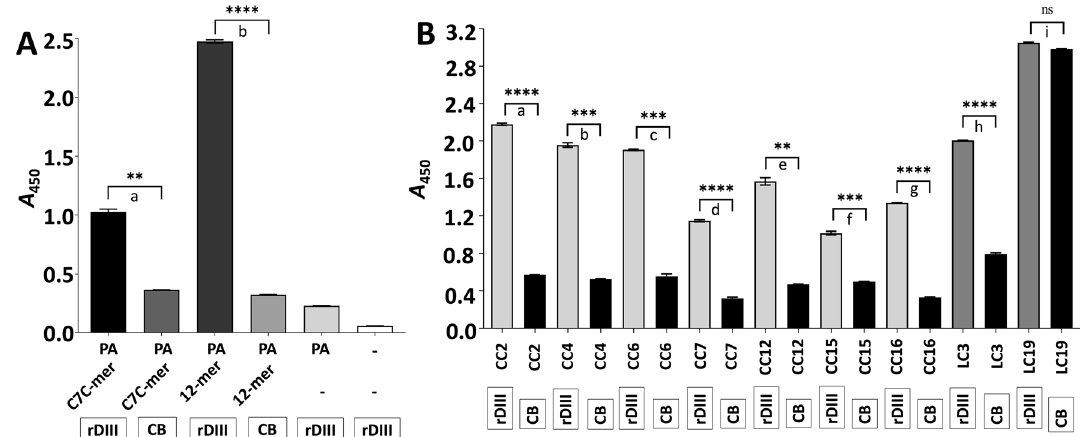
Figure 1. Confirmation of the interaction between rDIII and amplified phages using semi-quantitative ELISA. ( A ) Phage ELISA demonstrating the interaction between rDIII and C7C-mer and 12-mer phages amplified from the last round of biopanning. ( B ) Phage ELISA demonstrating the interaction of individual C7C-mer and 12-mer phage clones to rDIII. Framed reagents were coated into microtiter wells. Data present mean of triplicates with ± S.D. Asterisks indicate statistical significance. A statistical significance difference (P < 0.01, two-tailed P-value) was calculated with paired t-test. Statistics was performed with statistics tool of GraphPad Prism v8.4.3. In Panel ( A )—a: P = 0.0013; b: P < 0.0001. In Panel ( B )—a: P < 0.0001; b: P = 0.0002; c: P = 0.0007; d: P < 0.0001; e: P = 0.0014; f: P = 0.0010; g: P < 0.0001; h: P < 0.0001; i: P = 0.037 (ns). A – Absorbance; CB – coating buffer; rDIII – recombinant domain III; ns – non-significant; PA – primary antibody, CC – phage clone carrying 7-mer cyclic peptide; LC – phage clone carrying 12-mer linear